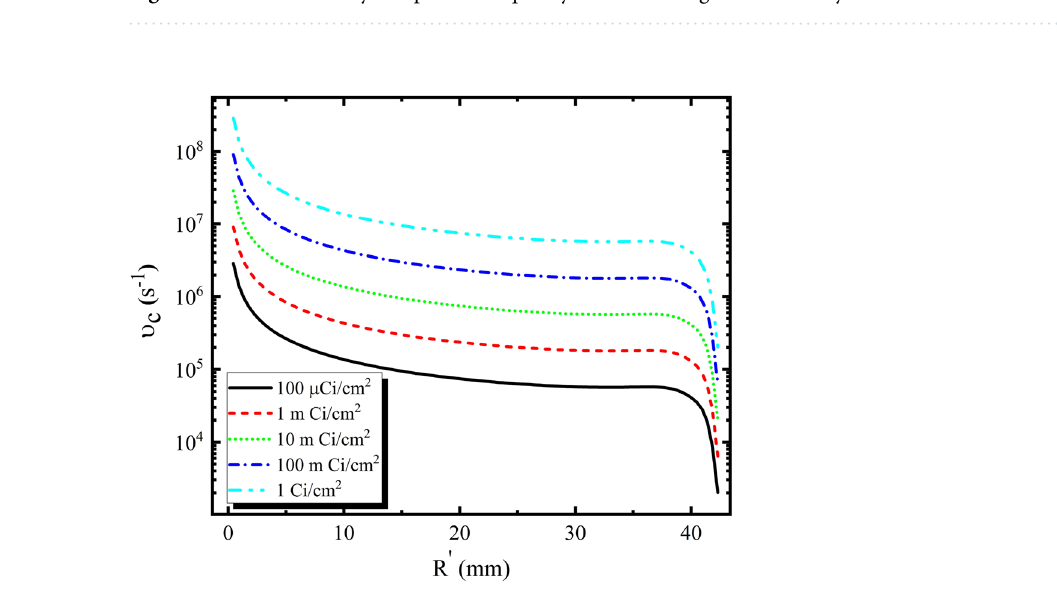
Figure 4. Collision frequency of surroundings around the